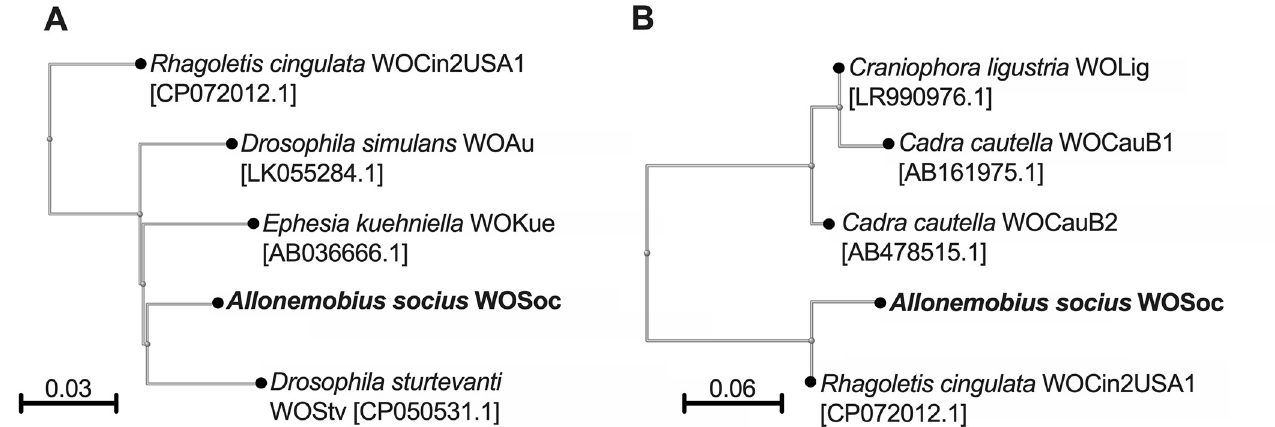
Fig 4. Phylogenetic comparison of WOSoc with published phage sequences. Neighbor-joining trees generated from published phage WO nucleotide sequences aligned to WOSoc A. Large terminase subunit (ORF2), showing homology to WOAu of Drosophila simulans and B. minor capsid protein (ORF7), showing high homology to WOCin2USA1 of the cherry fruit flu, Rhagoletis cingulata . Scale bars denote distance from the node as calculated by the NCBI Tree View software.